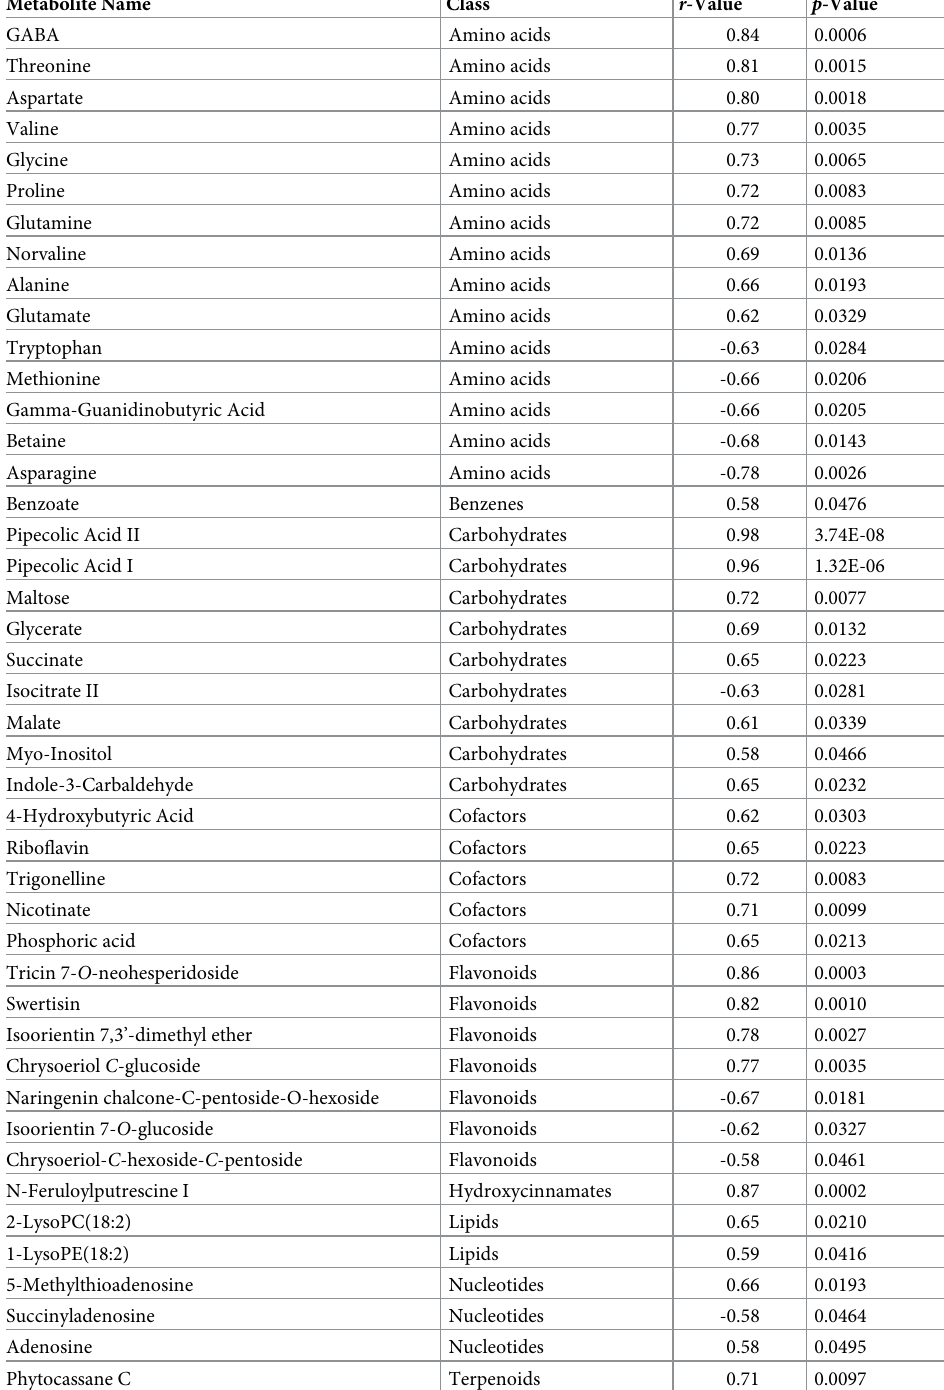
Table 4. Significantly associated metabolites between flag leaf and